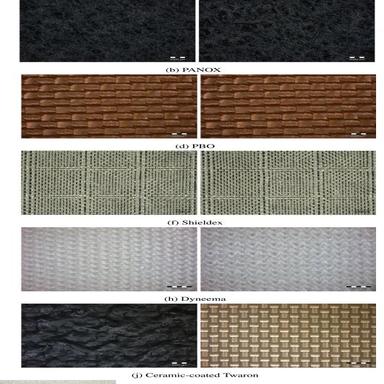
Overview of textile structures. In the left images the upper side is shown, whereas the bottom side is visible in the right images.